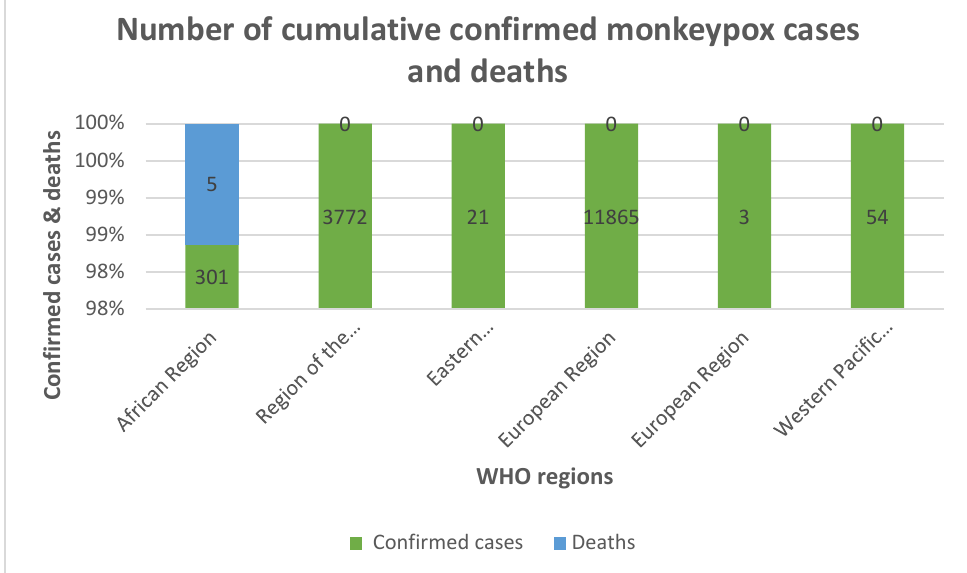
Figure 2. The majority of cases of this virus were observed in the European region (11,865), with few cases in the Western Pacific. The African region seemed to have the highest mortality among the regions, with 5 deaths reported due to monkeypox [27].